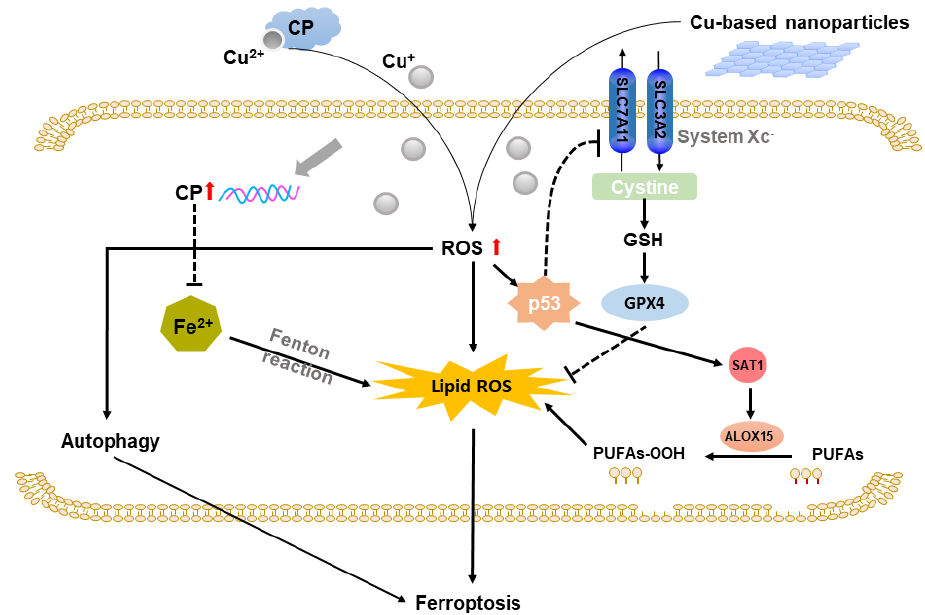
Figure 3. Schematic representation of copper-based ferroptosis.